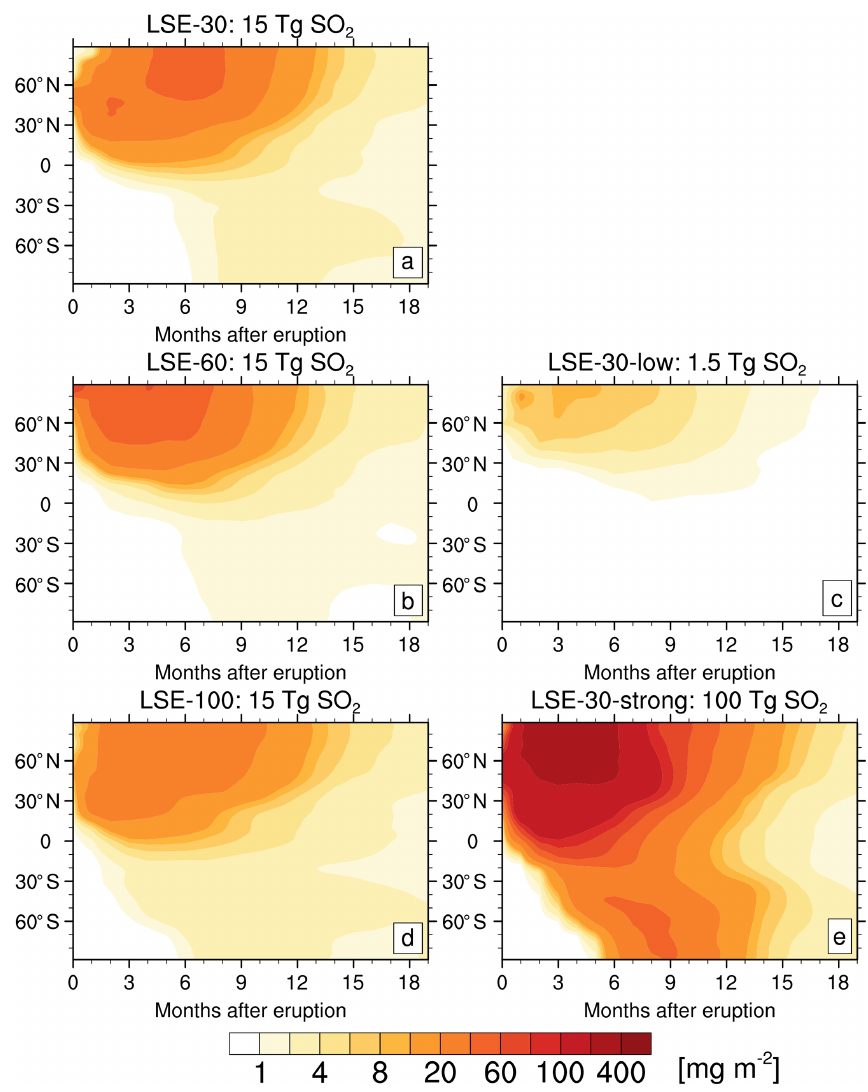
Figure 5. Hovmøller diagram of zonally averaged sulfur burden [mg(S)m − 2 ], vertical integral of sulfur, over a period of 1.5 years after the first eruption phase. The zero mark is in May, the month of the first eruption